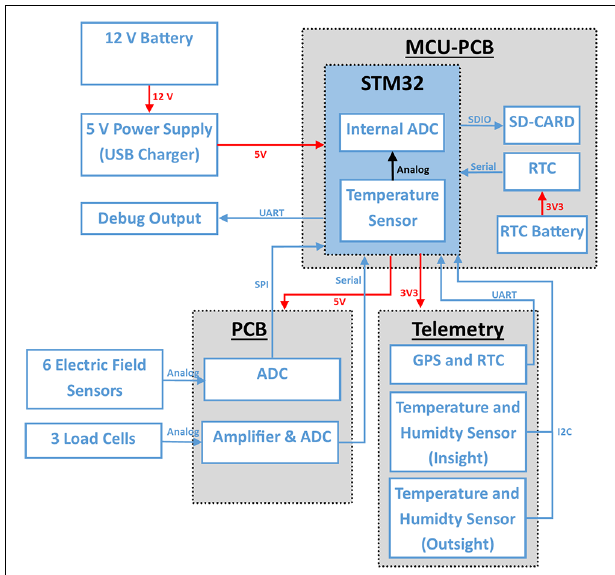
FIGURE 3 | System overview: red connections show power connections and blue data lines. The system is connected to a 12 V battery. A step down boost converter generates 5 V which is also regulated by the MCU-PCB to 3.3 V for some sensors. The electric field sensors are connected to an ADC (MCP3903, Microchip, AZ, USA) on the PCB. The STM32 reads out the ADC data with a sample rate of 5,000 Hz via SPI in a timer triggered interrupt. The activity sensor channels are read out at 200 Hz via I 2 C. The scales are connected via a custom serial protocol and are, like the temperature and humidity sensors (I 2 C) read out every 120